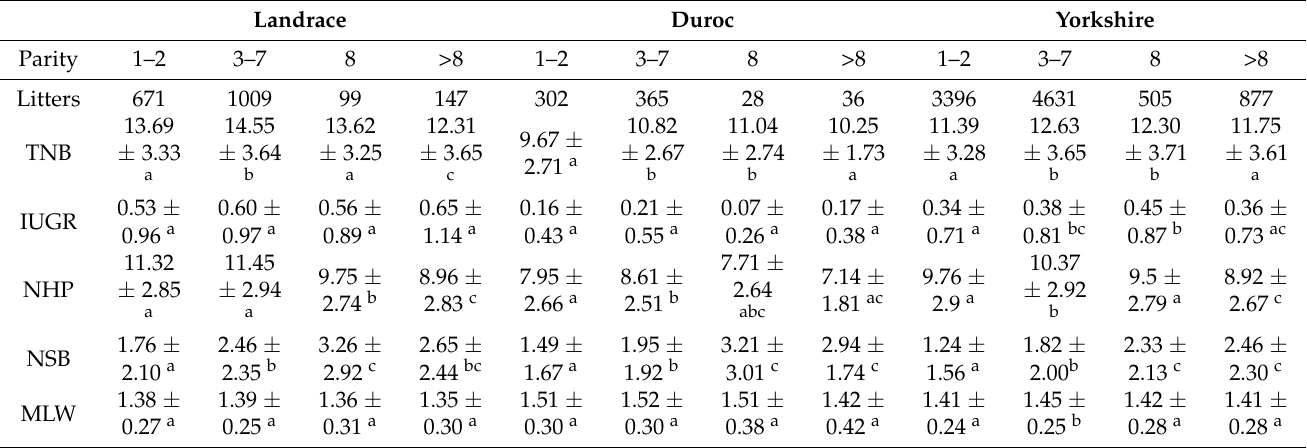
Table 1. The difference of reproductive performance of sows at 1st–2nd, 3rd–7th, 8th and >8th parities. Landrace